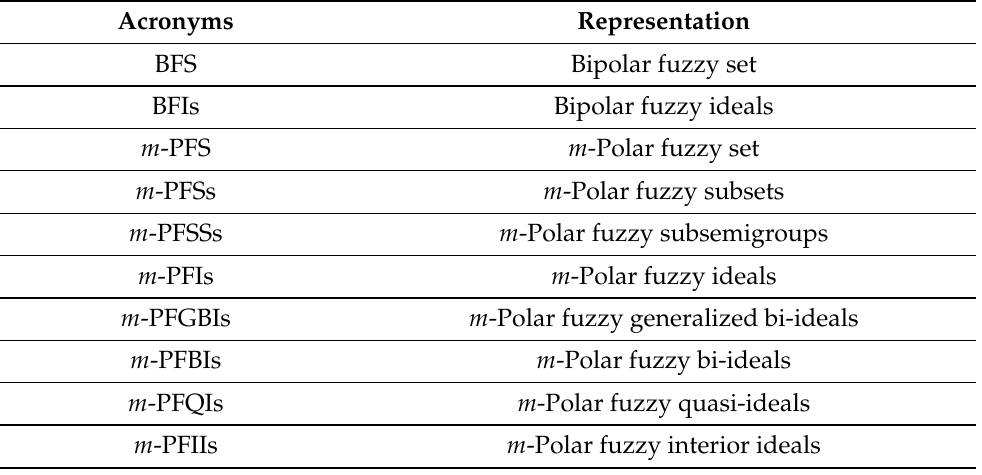
Table 2. List of